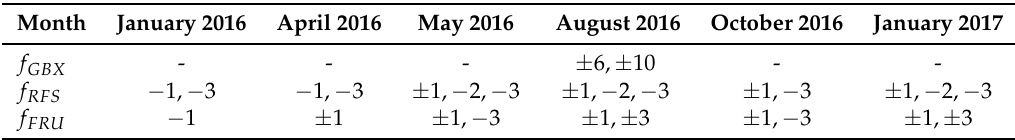
Table 4. Fault-related frequency harmonics found on the current spectra from January 2016 to January 2017 with DFIG at sub-synchronous